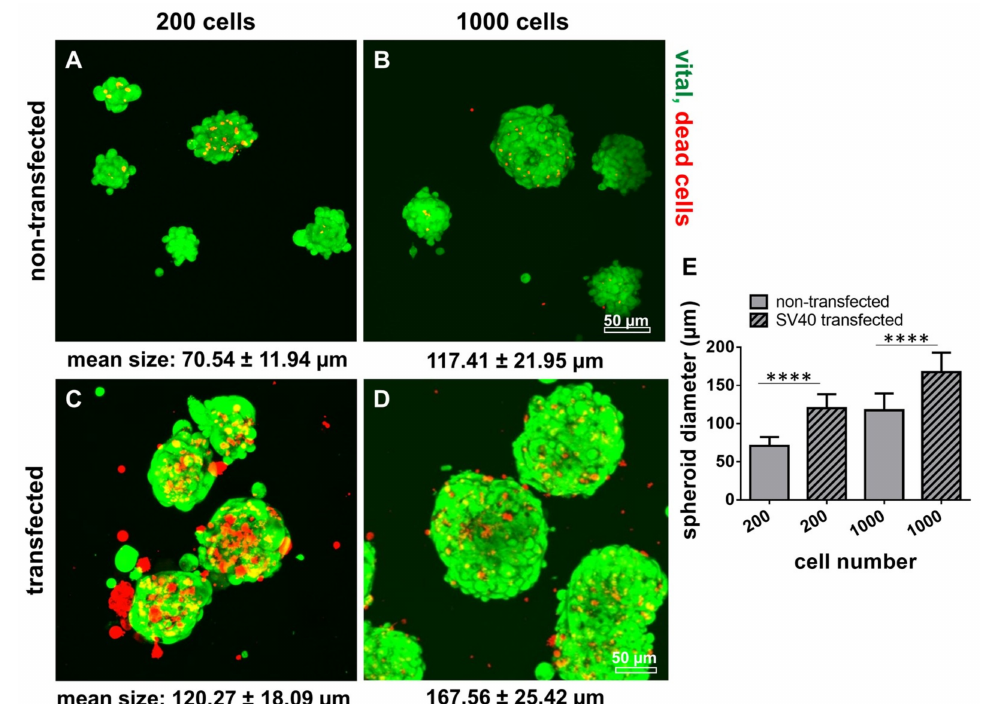
Figure 10. Microspheroid formation by non-transfected and SV40 transfected human ACL ligamentocytes: Spheroid size as well as cell vitality. 200 ( A , C ) and 1000 ( B , D ) human ACL ligamentocytes per spheroid either non-transfected (A,B) or SV40 transfected ( C,D ) were allowed to aggregate for 5 d using a spheroid multiwell plate. Live / Dead staining was performed and spheroid diameters were measured ( E , 48 h). Scale bars: 50 µ m. **** p <